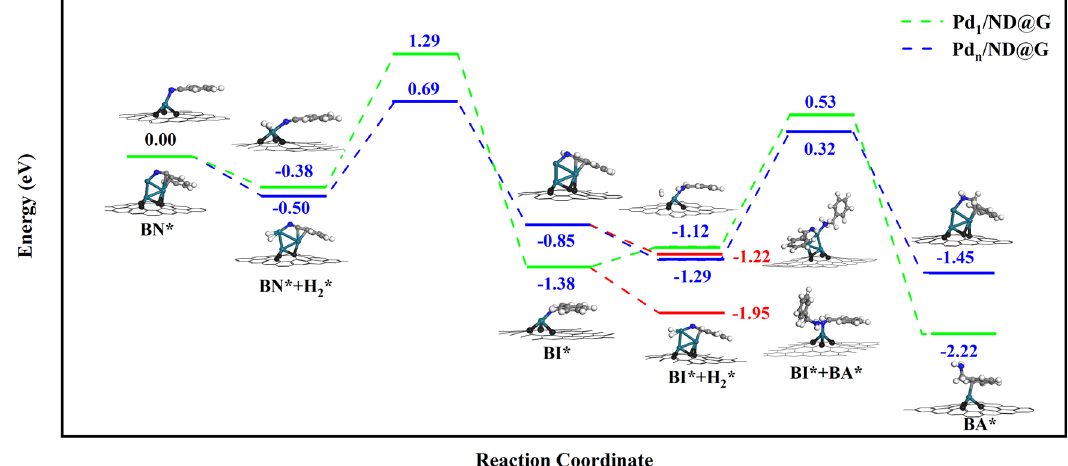
Fig. 4 Step-by-step hydrogenation mechanism of benzonitrile to benzylamine on Pd1/ND@G and Pdn/ND@G. Color code: Pd 1 /ND@G (green line) and Pd n /ND@G (blue line). Pd cyan, C gray, H